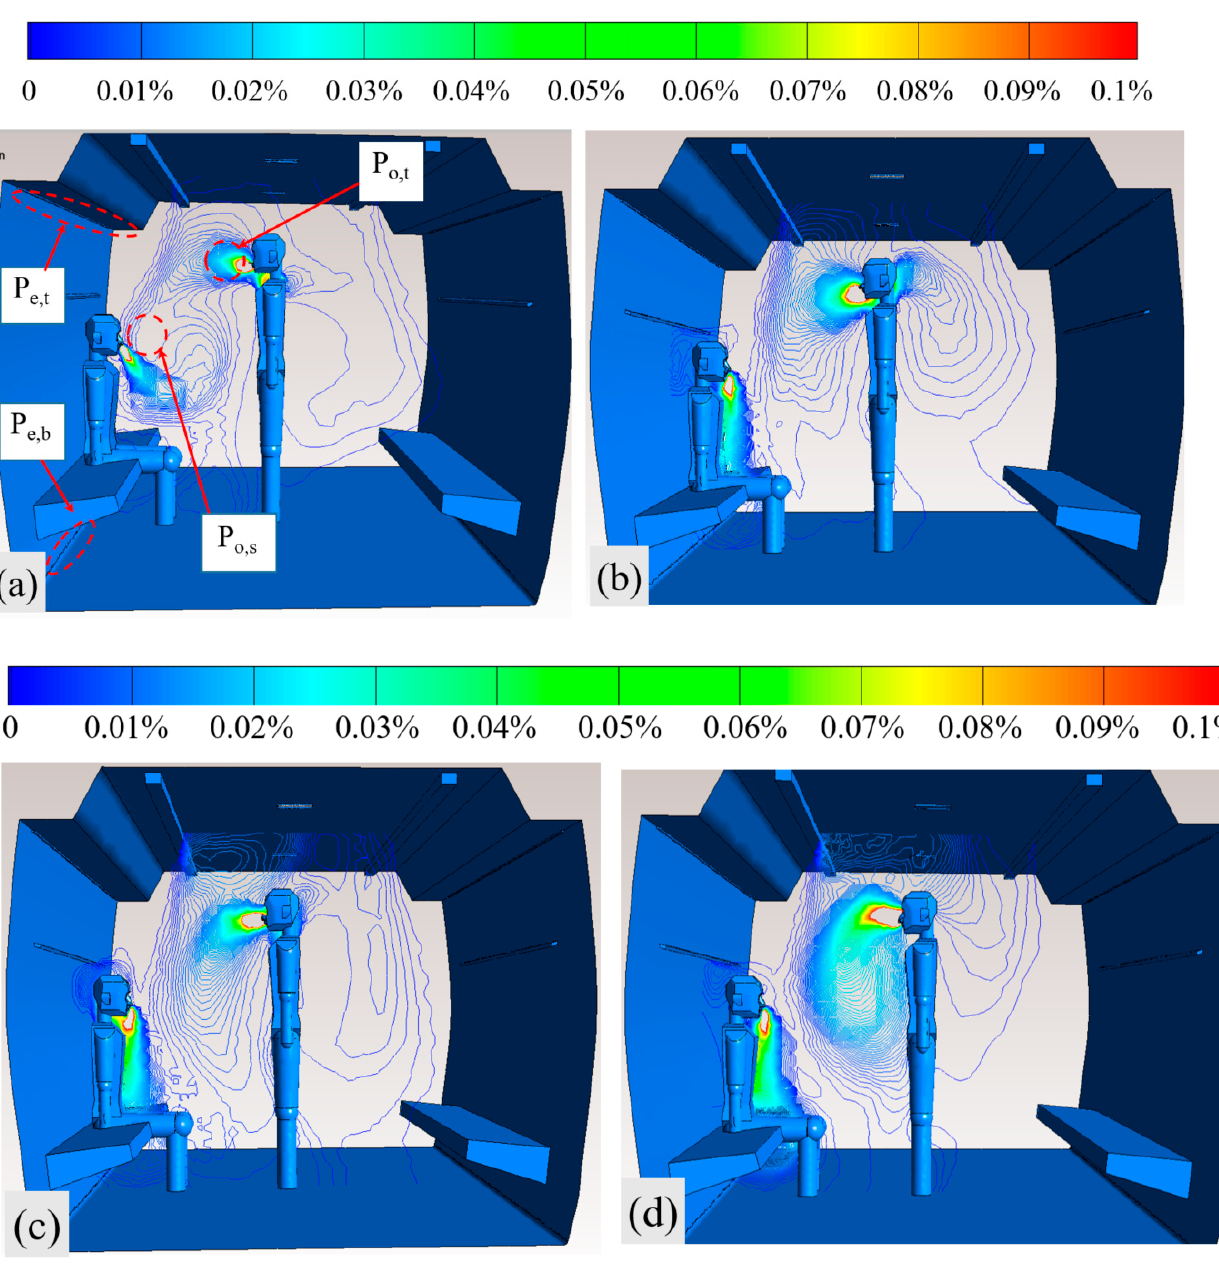
Figure 5. Concentrations of CO 2 in cars equipped with ( a ) CV and ( b – d ) SV; Q = 8500, 8500, 7850, and 7200 m 3 /h, respectively ( a – d ).